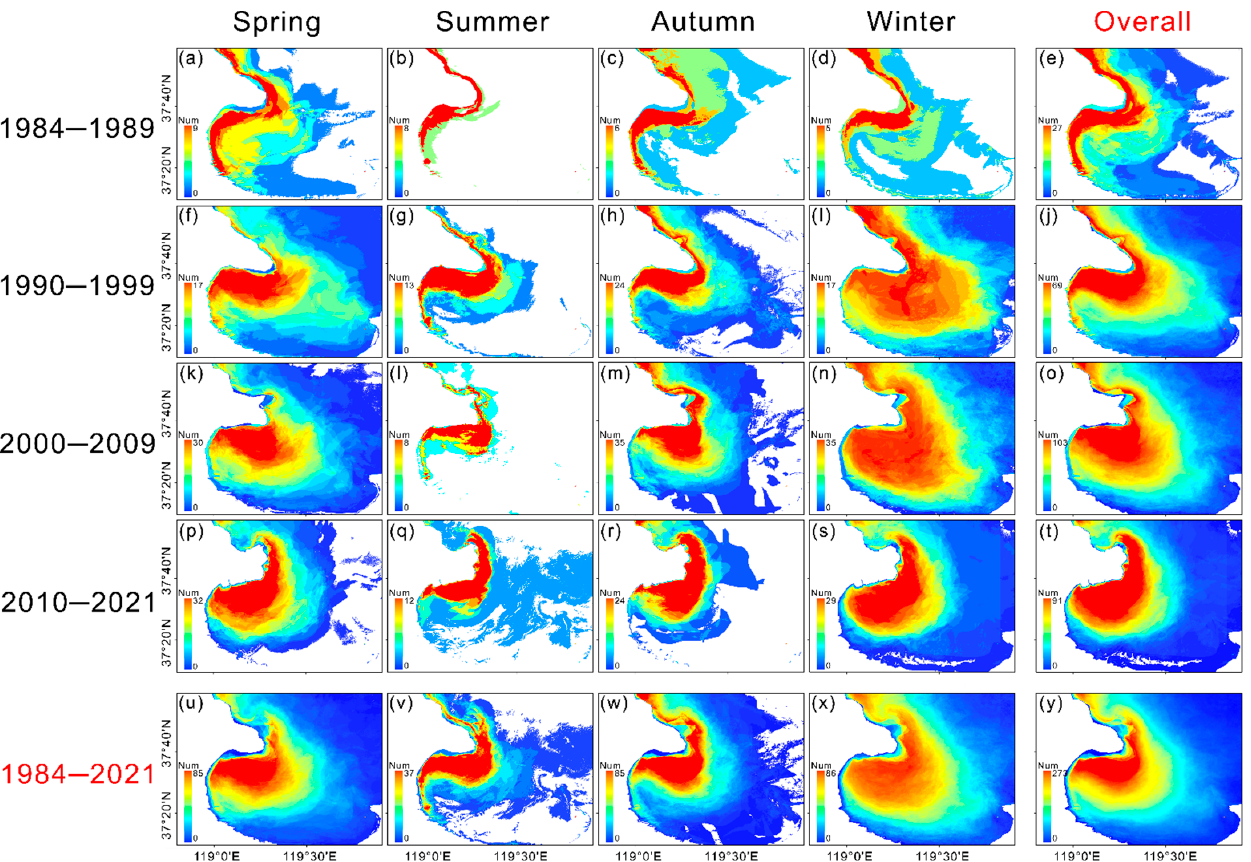
Figure 7. The number of TMZ occurrences during different time periods in the Yellow River estuary.